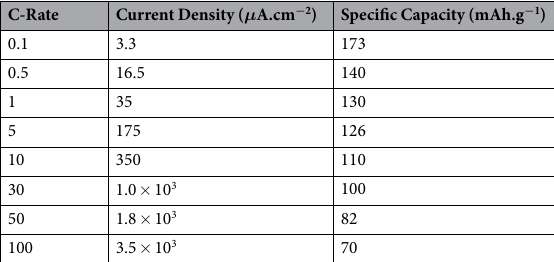
Table 1. Summary of the electrochemical properties of nLTO/SWCNT composites. The electrodes presented a LTO mass load of 200 μ g.cm 2 and a thickness of 1 μ m.